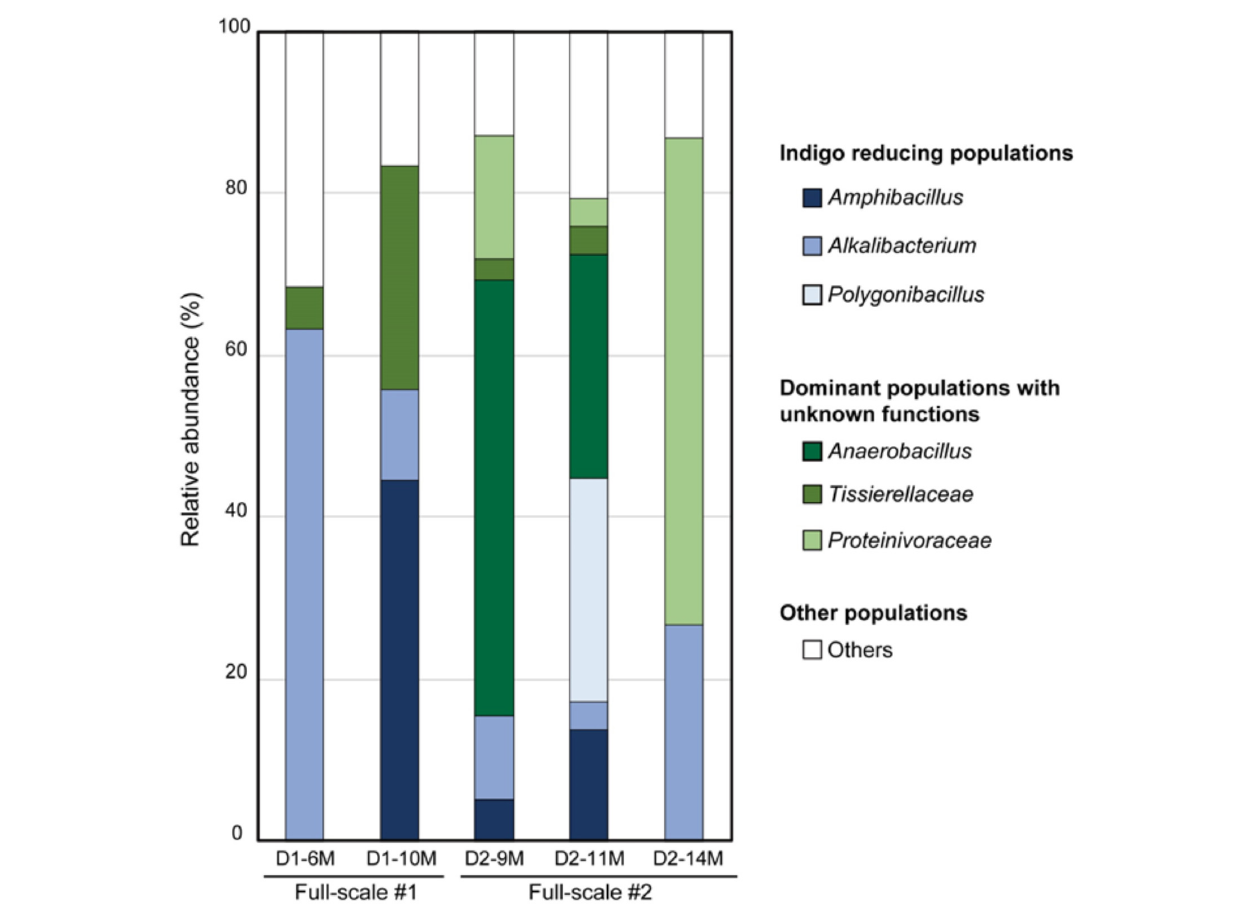
FIGURE 5 | Changes in the bacterial community of the indigo fermentation fluid in aged phases (D1-6M, D1-10M, D2-9M, D2-11M, and D2-14M). The relative abundance of each taxon is shown. D1-6M, 1st-batch sample, aged 6 months, obtained from Date City (42 ◦ 42 (cid:48) N, 140 ◦ 42 (cid:48) g E); D1-10M, 1st-batch sample, aged 10 months, obtained from Date City; D2-9M, 2nd-batch sample aged 9 months, obtained from Date City; D2-11M, 2nd-batch sample, aged 11 months, obtained from Date City; D2-14M, 2nd-batch sample, aged 14 months, obtained from Date City. This figure was cited from a figure in Okamoto et al. (2017) with some modifications. This citation was permitted by